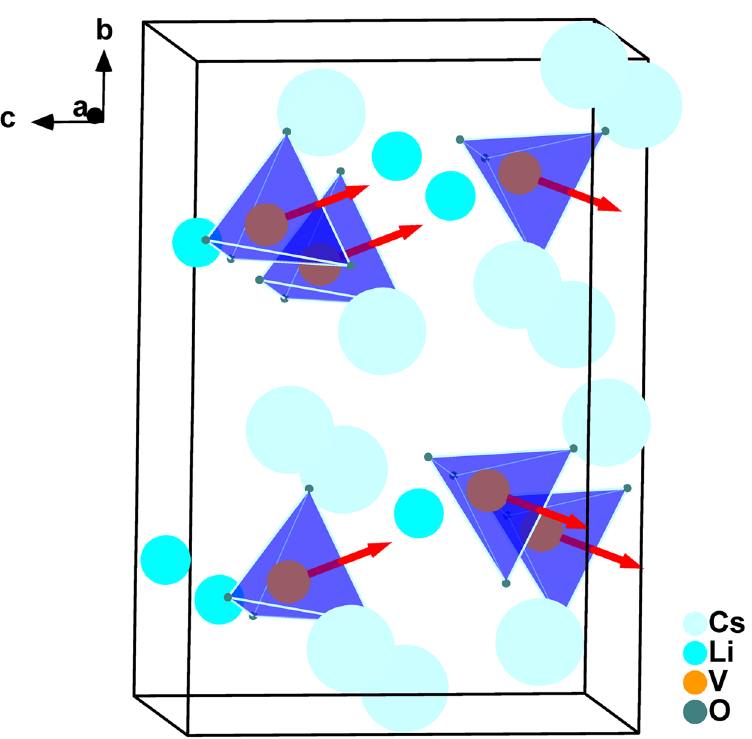
Figure 7. The direction of the dipole moments for the VO 4 tetrahedra in the unit cell of CLVO. (The red arrows indicate the approximate directions of the dipole